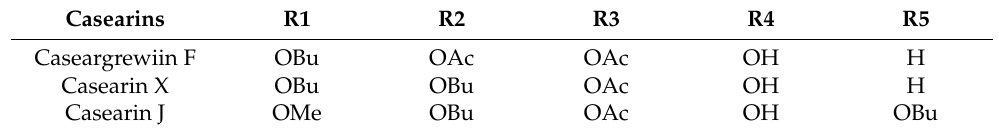
Table 3. C. sylvetris clerodane diterpenes and their substituents R1 to